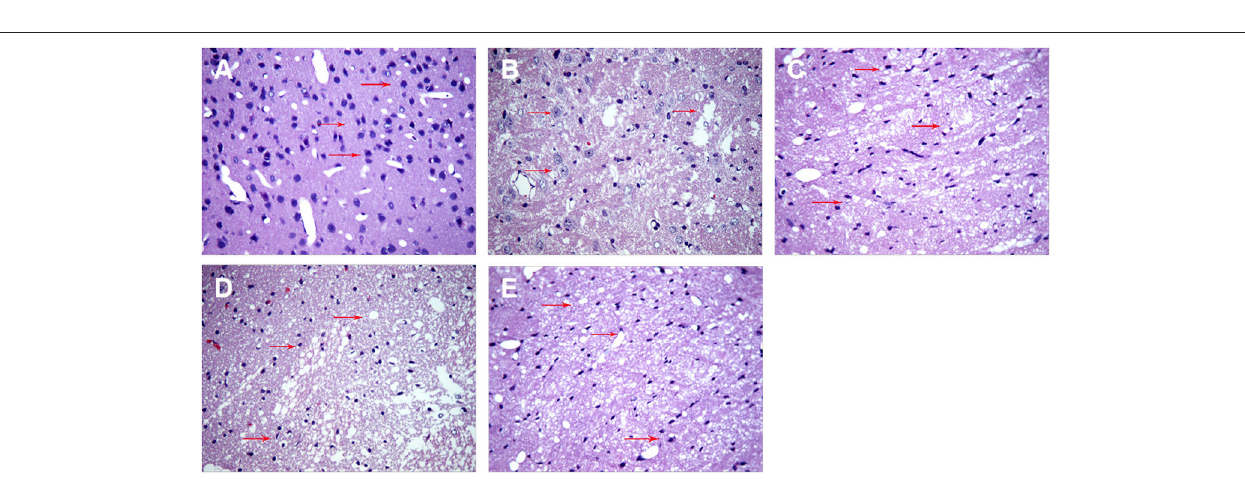
FIGURE 4 | SA mitigates cell injury-edema, inflammatory infiltration in the peri hemorrhagic penumbra of rats with ICH. Brain tissue structure was analyzed at 3 days after sham or ICH surgery by hematoxylin-eosin staining. Representative images are shown from the (A) sham, (B) ICH, (C) 3-MA, (D) SA, and (E) SA + 3-MA groups. Red arrows indicate inflammatory cells and necrotic cells at the site of injury. Magnification: 400 × . ICH, intracerebral hemorrhage; SA, scalp acupuncture; 3-MA,